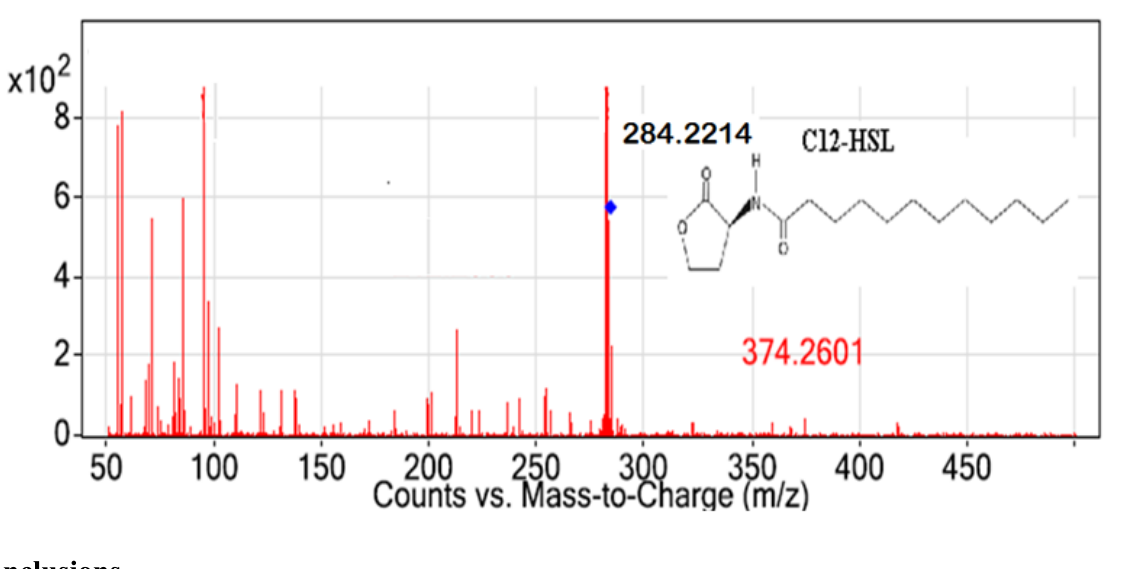
Figure 5. ESI-MS spectrum of C12-HSL ( m/z 284.2214, 7.708